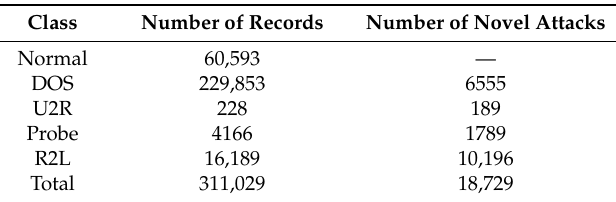
Table 2. The distribution of the KDD test